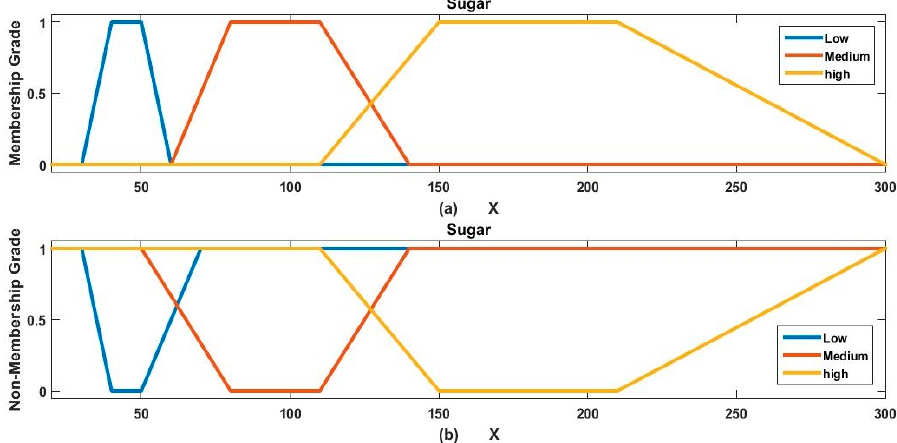
Figure 3. Three linguistic categories of sugar with their trapezoidal membership ( a ) and non-membership grades ( b ).